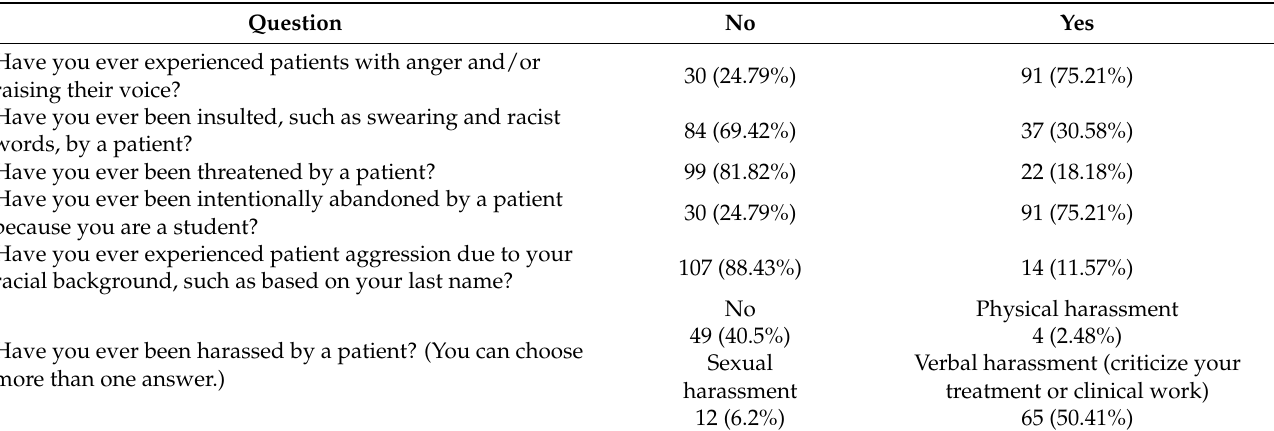
Table 2. Experience of patient aggression among study